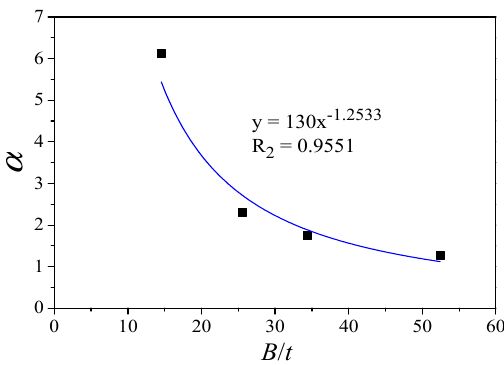
Figure 11. Influence factor α of width to thickness ratio.